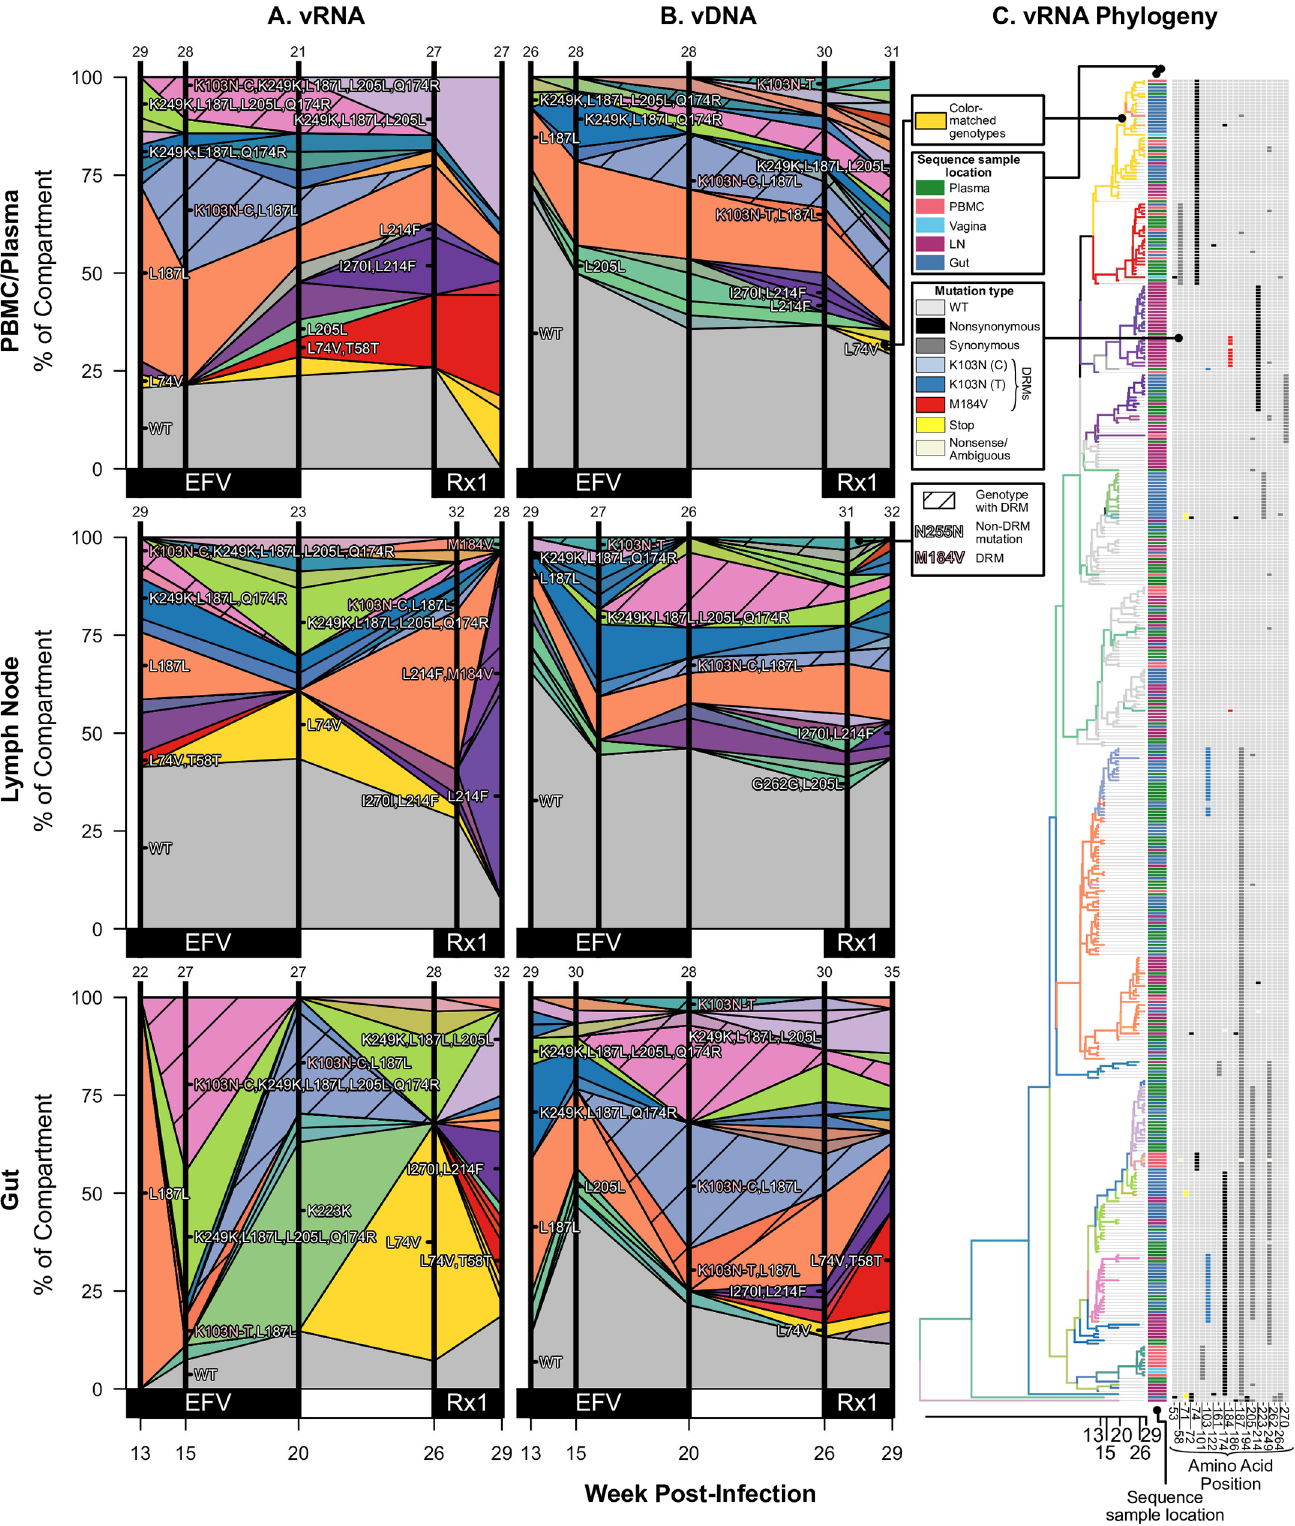
Fig 4. Drug resistance spreads dynamically across severalcompartments in macaque A99165over the course of treatment. Coloredpolygons show the prevalence of different genotypes of RT-SHIV RNA (A) or DNA (B) over time in different compartments. Vertical distanceat black vertical lines